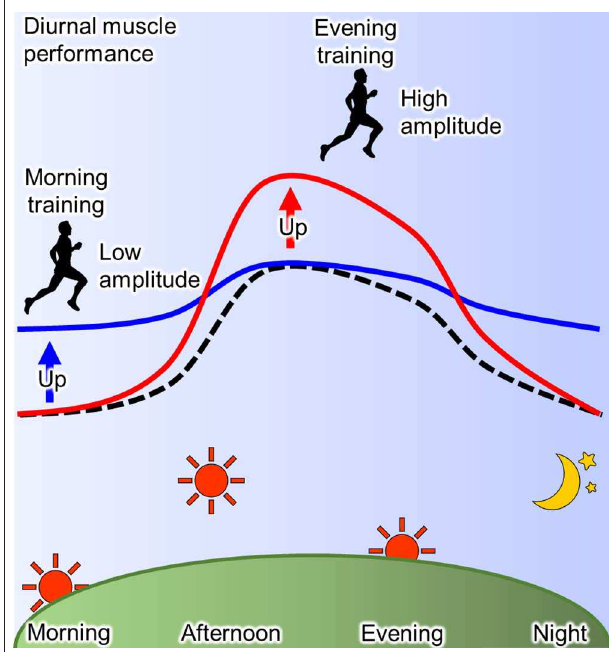
FIGURE 3 | Scheme for effect of training-time on diurnal physical performance. The muscle performance exhibits diurnal variation with the peak at afternoon and the trough at morning and night (dotted line). This diurnal characteristic of muscle performance is changed by training and its effect depends on the time of day ( 93). Morning training increases the performance in morning resulting in the low amplitude (blue line), while evening training increases it in the evening resulting in the high amplitude (red